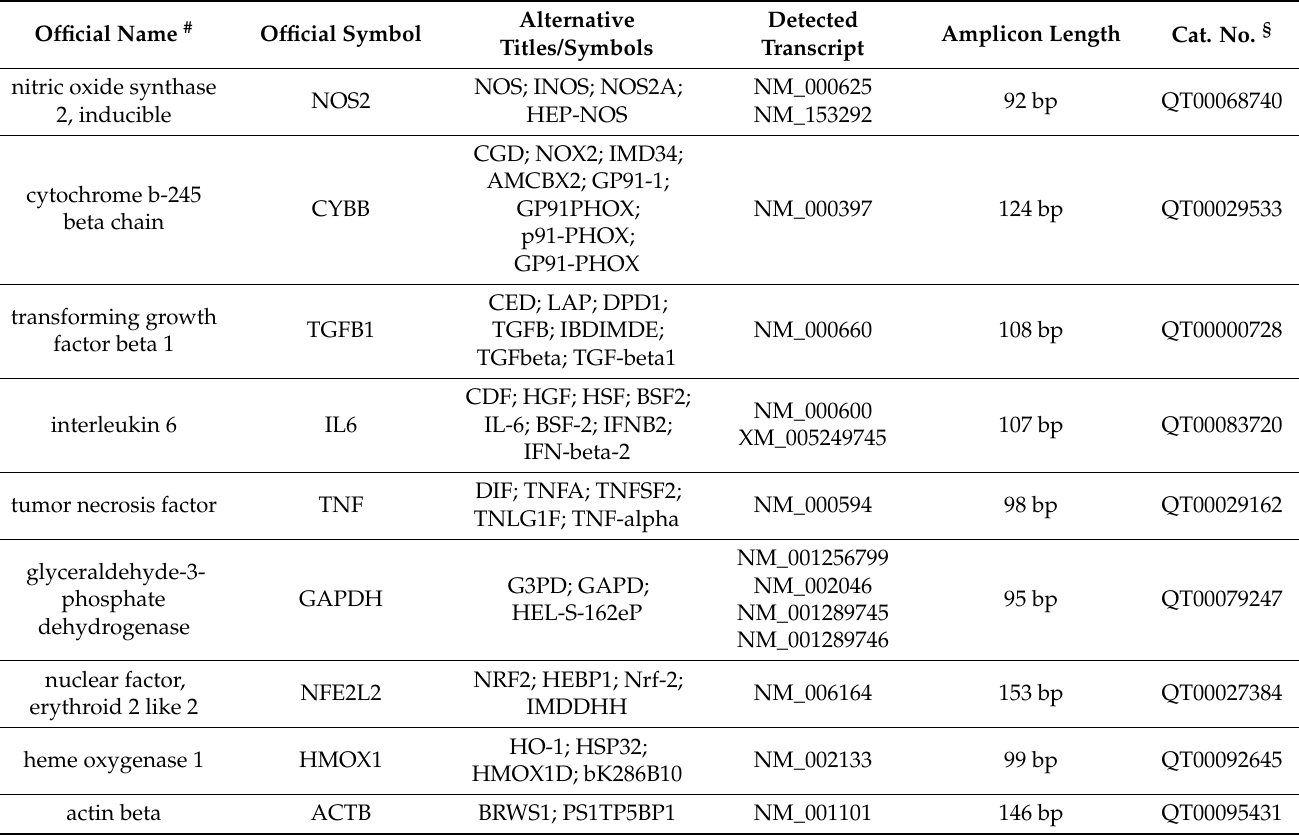
Table 2. List of primers used for quantitative real-time PCR